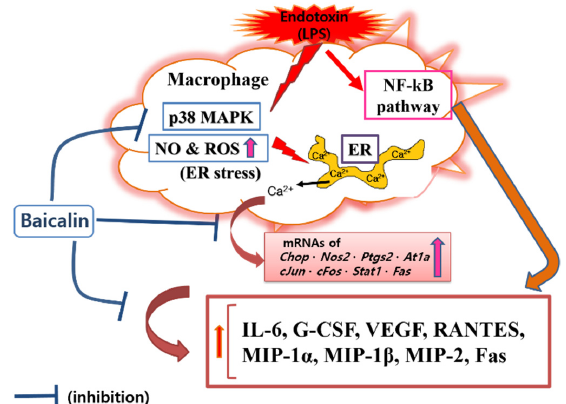
Figure 7. Proposed mechanisms underlying the inhibitory effect of baicalin in LPS-activated RAW 264.7 macrophages via the calcium-CHOP pathway rather than the NF- κ B pathway.